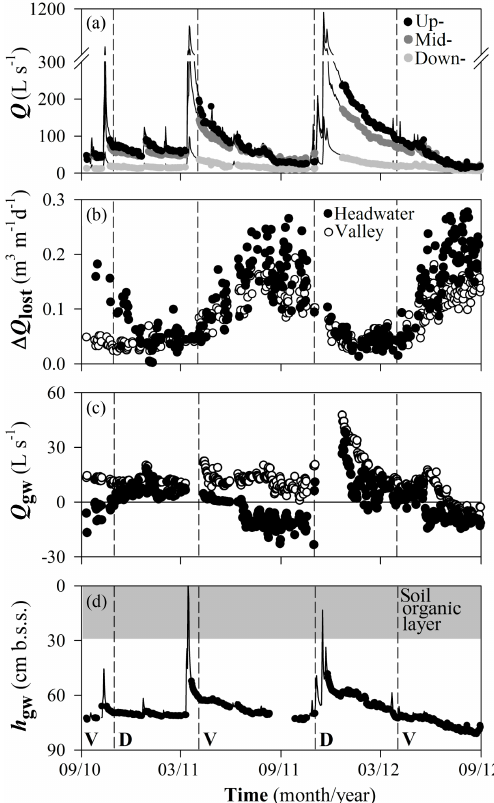
Figure 2. Temporal pattern for the period 2010–2012 of (a) stream discharge ( Q ) at the up- (light gray), mid- (dark gray), and down- stream (black) sites, (b) riparian evapotranspiration ( (cid:49)Q lost ) esti- mated as the difference in the diel variation in discharge between the top and the bottom of the headwater (white) and valley (black) reaches, (c) daily net riparian groundwater inputs ( Q gw ) for the headwater (white) and valley (black) reaches, and (d) groundwater table fluctuation ( h gw ) at the valley bottom. In (c) , the Q gw = 0 line is shown as a reference of nil net riparian to stream-water inputs; Q gw > 0 and < 0 indicates when the stream reach was net gaining and net losing water, respectively. In (d) , the mean soil depth of the A horizon is indicated. V: vegetative period, D: dormant period.